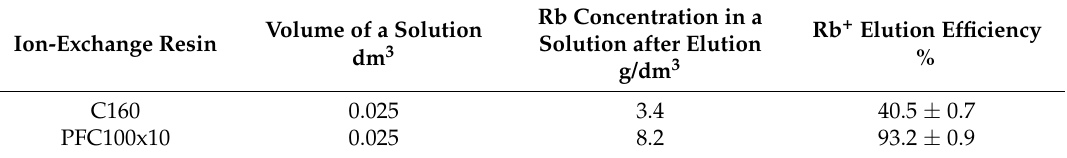
Table 4. Results of ion-exchange resin selection for rubidium sorption.